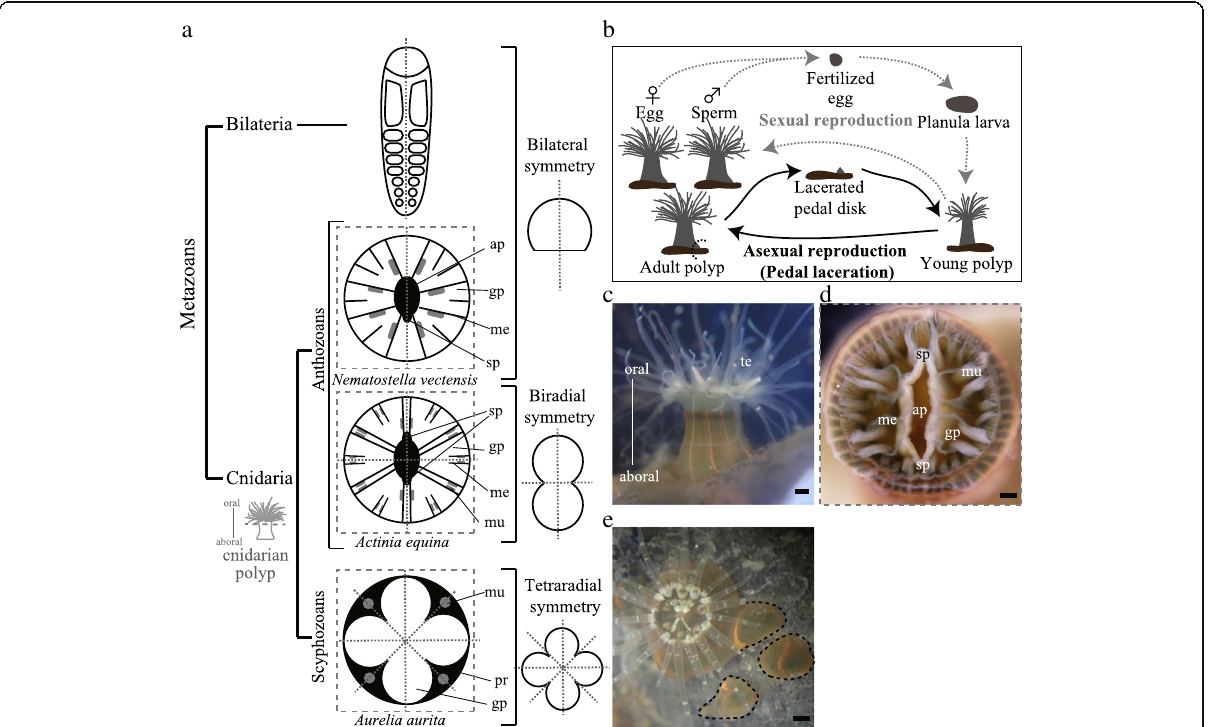
Fig. 1 Body symmetries on metazoan phylogeny. a Schematic diagram of a bilaterian embryo and three representative cnidarian polyps with different symmetry types. A section of cnidarian polyps (gray dashed line) perpendicular to the oral – aboral axis representing the positional arrangement of gastric pouches. Symmetry planes of these arrangements are represented by gray dotted lines. b Schematic of life cycles for sexual and asexual reproduction (pedal laceration) modes. c External view of D. lineata . Orange-striped patterns orient to the oral – aboral axis in a longitudinal green body column. Scale bar, 2 mm. d Internal view of D. lineata. Horizontal cut of a polyp showing the actinopharynx, siphonoglyph, muscles, and mesenteries. Scale bar, 200 μ m. e Asexual reproduction of a few individuals (framed with black dashed lines) by pedal laceration. Scale bar, 1 mm. ap: actinopharynx, gp: gastric pouch, sp: siphonoglyph, mu: muscle, me: mesentery, pr: partition, te: